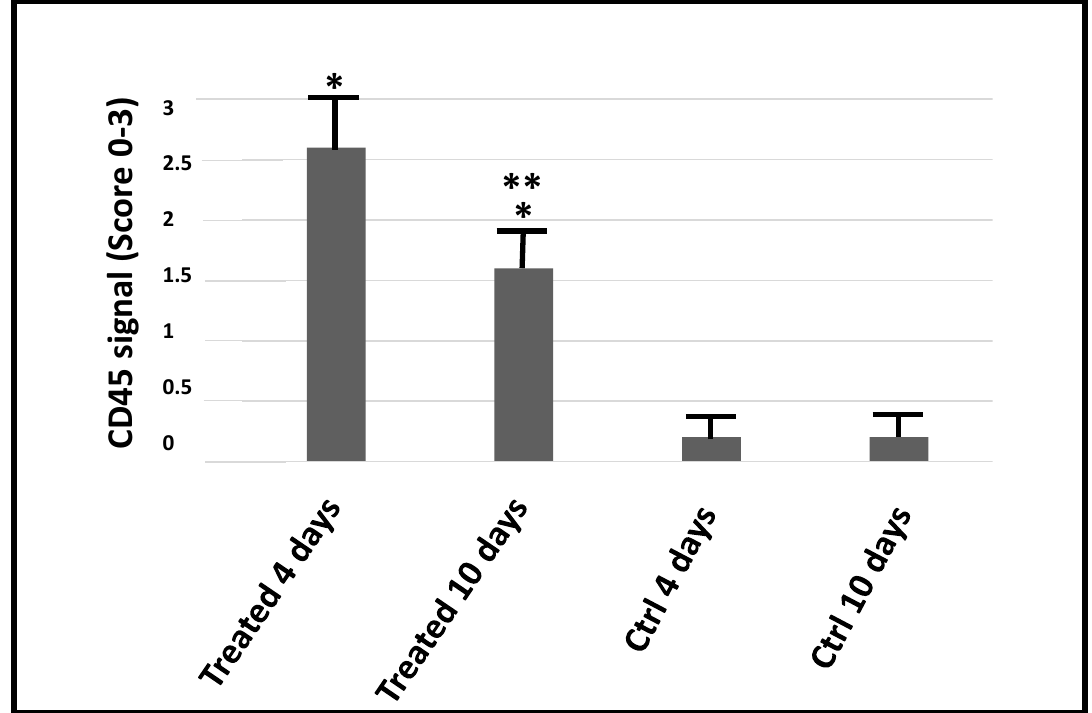
Figure 4. Evaluation of CD45 immunohistochemical staining in skeletal muscle. The graph shows the score of CD45 immunoreactivity in muscles treated with electroporation and in control animals (Ctrl). The single asterisk indicates a statistically significant di ff erence in the scores between treated and untreated mice at the two time points, while a double asterisk indicates a statistically significant di ff erence in the scores between the two treated groups.